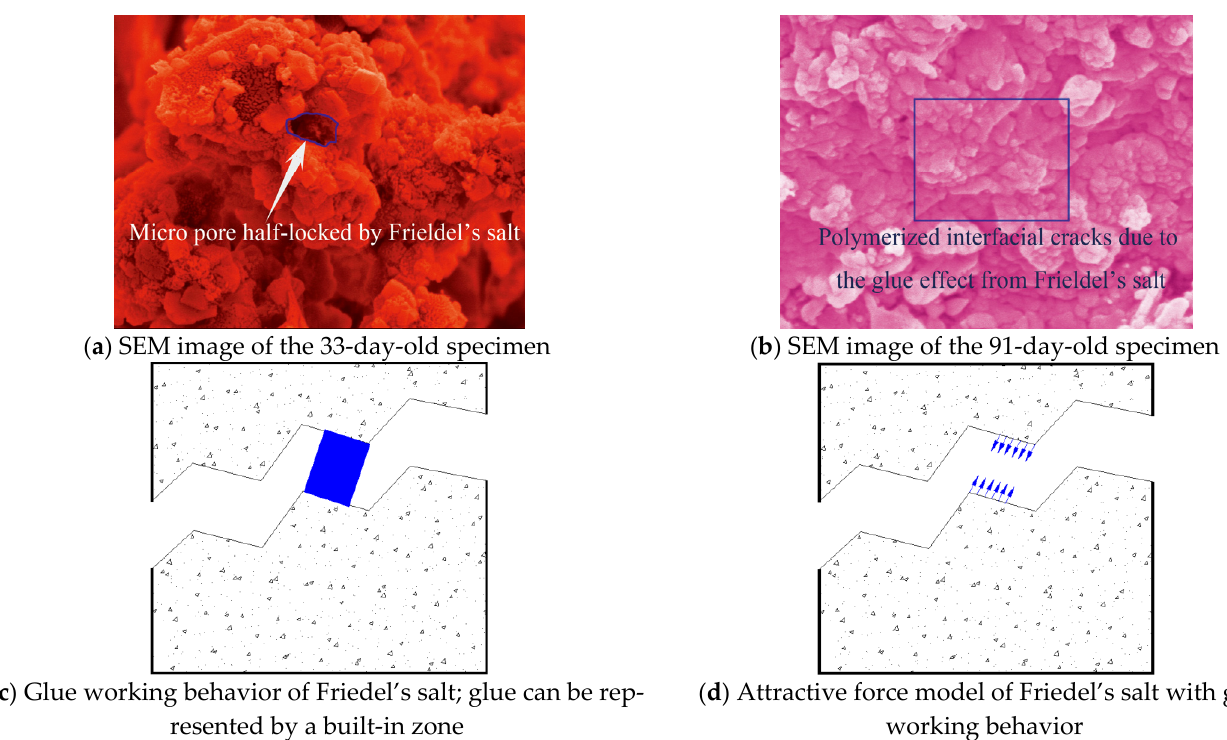
Figure 11. Friedel’s salt working model in grown specimens. Friedel’s salt in grown specimens played the glue role in polymerizing the interfacial cracks ( a , b ). Hence, the attractive force was generated along the interfacial cracks ( c , d ), which ensured higher toughness and resistance of the mortar under the uniaxial compression condition.